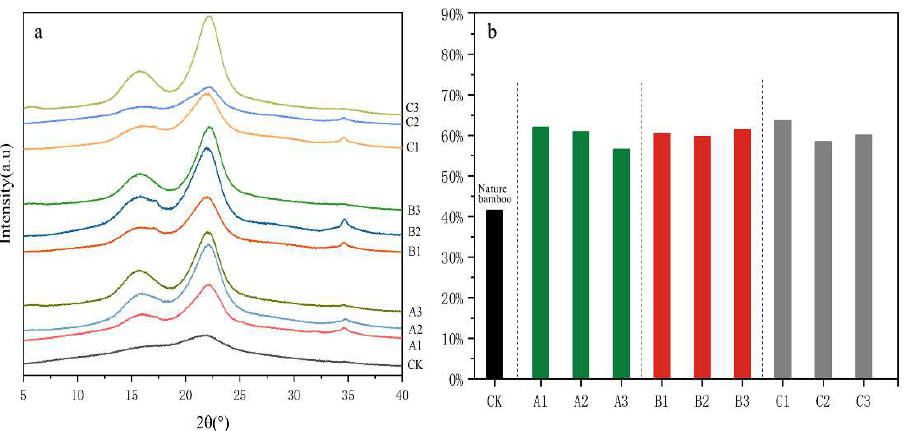
Figure 3. ( a ) X-ray diffraction (XRD) patterns of natural bamboo fibers (CK) and bamboo fibers treated with different delignificati on processes. ( b ) The crystallinity values of natural bamboo fibers (CK) and bamboo fibers treated with different delignification processes.